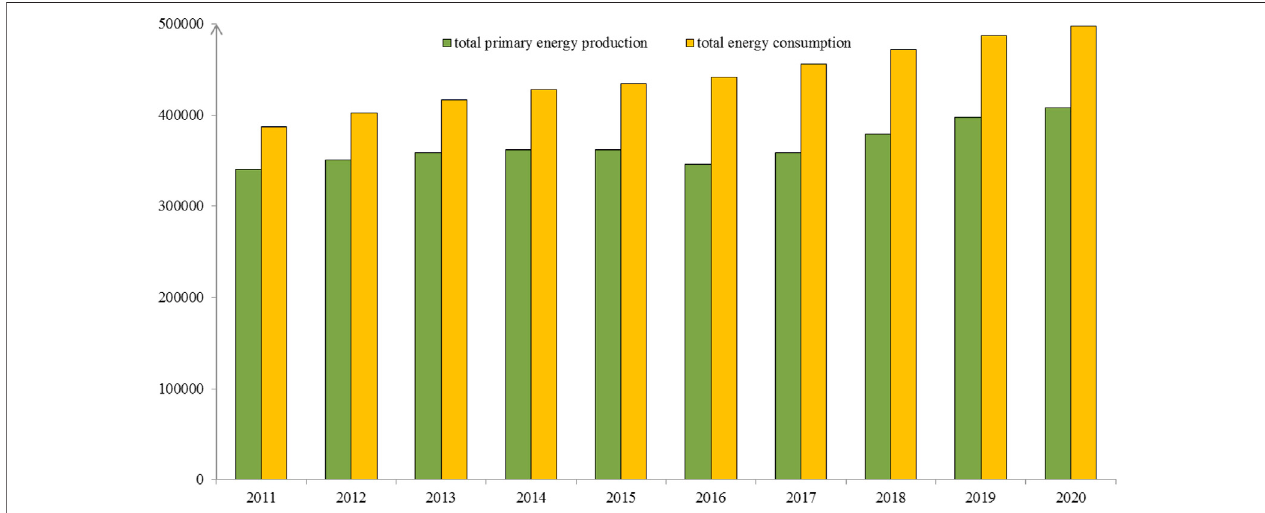
FIGURE1| TotalprimaryenergyproductionandtotalenergyconsumptioninChinaduring2011 – 2020(10 4 tce).Source:Theauthorsearchedtheinformationfrom TotalPrimaryEnergyProductionandItsComposition ,and TotalEnergyConsumptionandItsComposition inthe ChinaStatisticalYearbook 2021respectively.Note:The unit “ tce ” indicates “ ton coal equivalent ” , and these quantities should be calculated by coal equivalent calculation based on the China Energy Statistical Yearbook